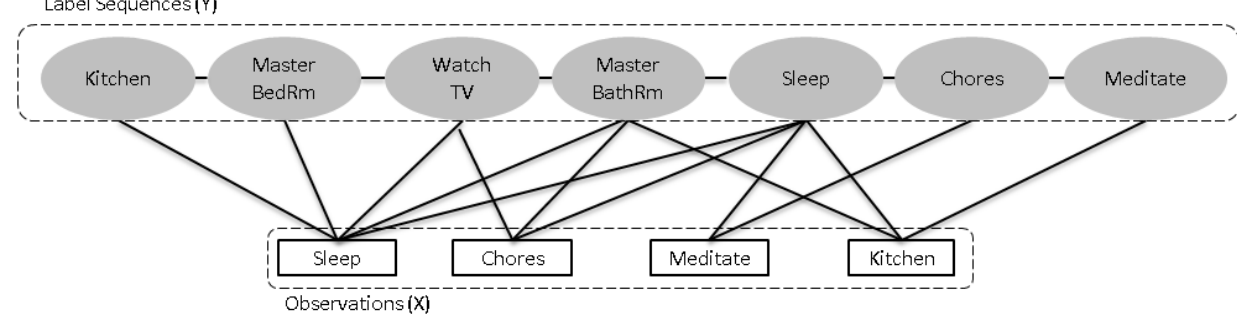
Figure 3. The design of CRF for activity